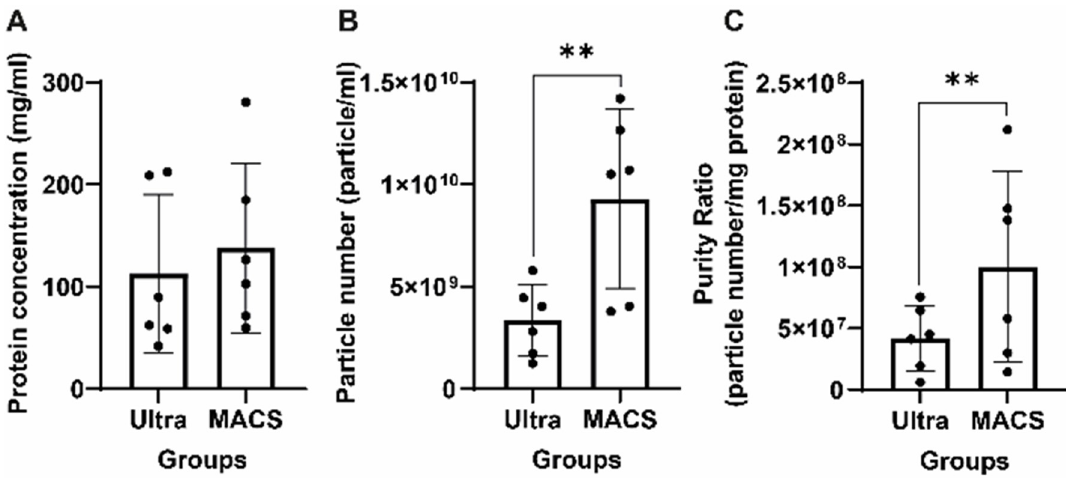
Fig 1. Particle yield and purity analysis of exosomes. Interleaved scatter bar graphic presents the descriptive data of (A) descriptive data of protein concentration (mg/ml) (B) particle number and (C) purity ratio analysis of MACS and ultracentrifugation groups. �� indicates p < 0.05. ( ● ) presented each individual measurement